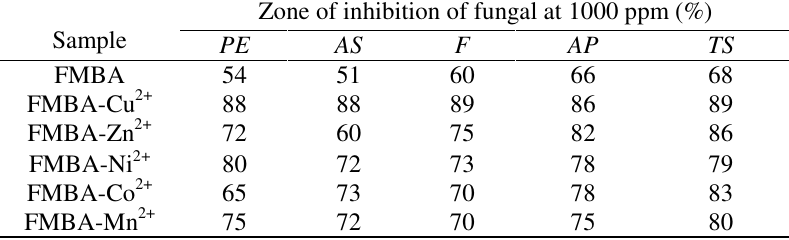
FMBA-Mn2+ FMBA-Zn2+ D*=Diamagnetic Table 3 . Antifungal actvity of FMBA ligand and its metal celates Zone of inhibition of fungal at 1000 ppm (%) Sample PE AS F